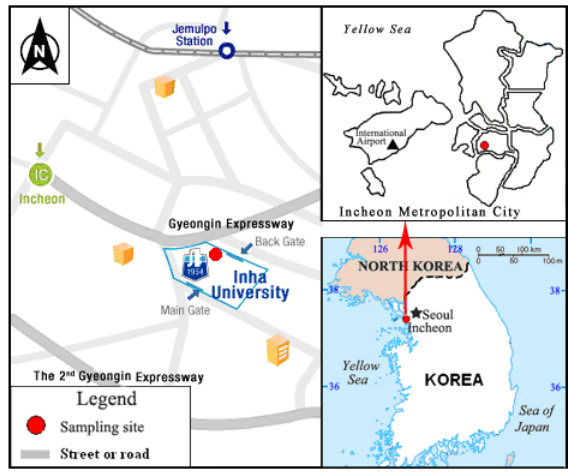
Fig. 1. A schematic map of the sampling site